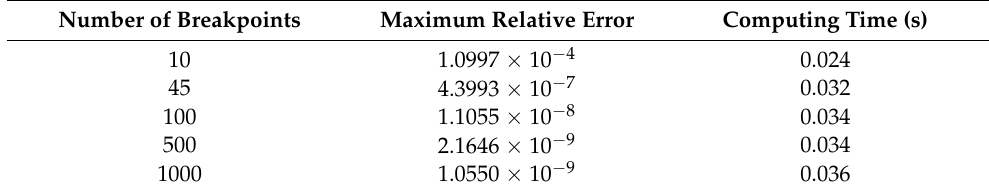
Table 3. Comparison of the accuracy of TSE method with different breakpoint